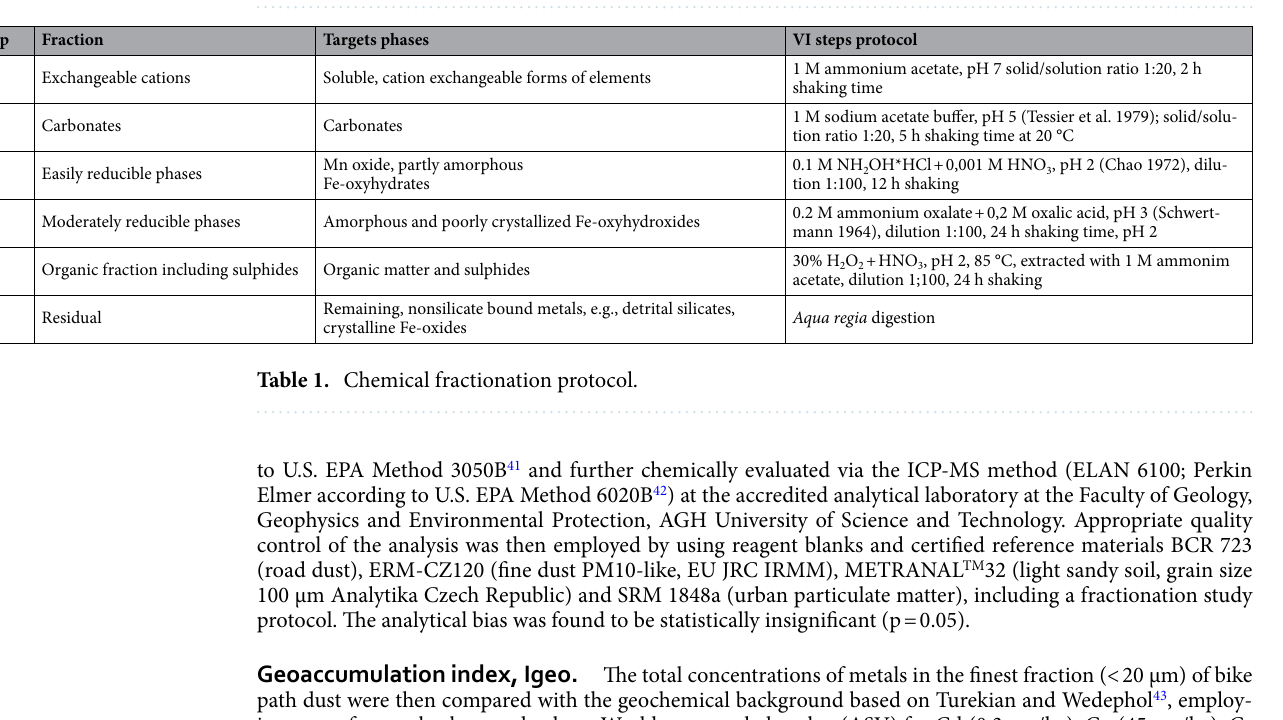
Figure 1. Sampling sites location and geographical coordinates.